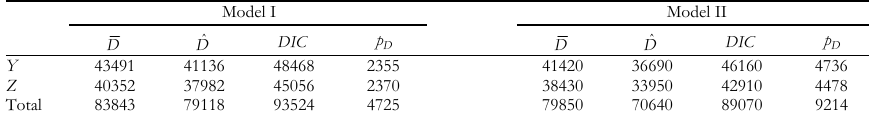
Model comparison: DIC Model I Model